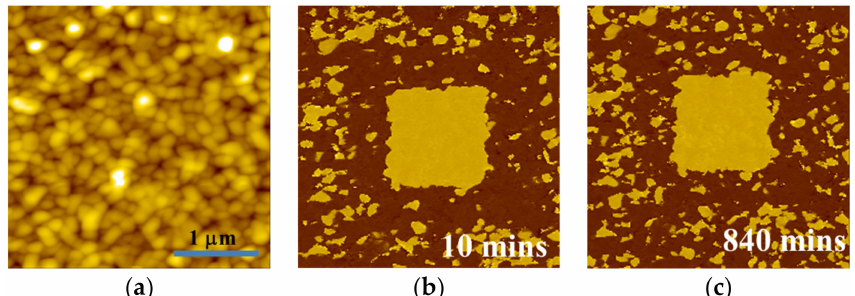
Figure 3. The ( a ) topography image of BFMO film with the deposition oxygen pressure of 2 Pa. The corresponding piezoresponse phase images are shown after being depolarized with − 5 V voltage with the tip earthed for ( b ) 10 min and ( c ) 840 min.